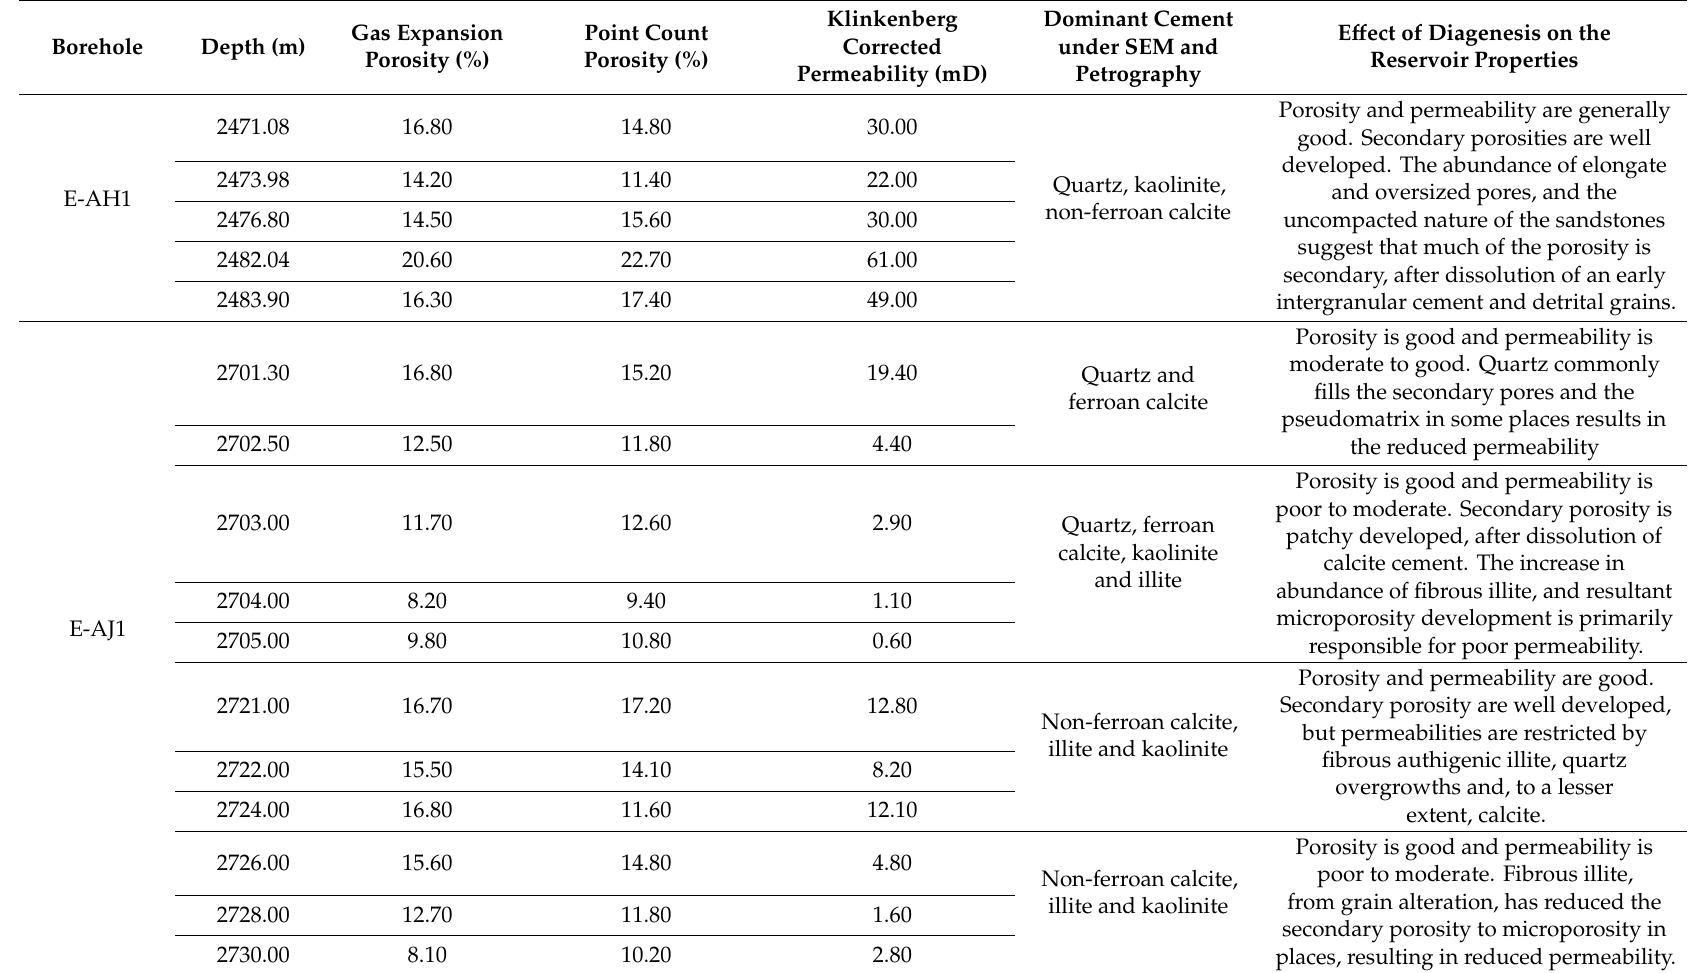
Table 8. The summary of the reservoir properties of the sandstones of the Bredasdorp